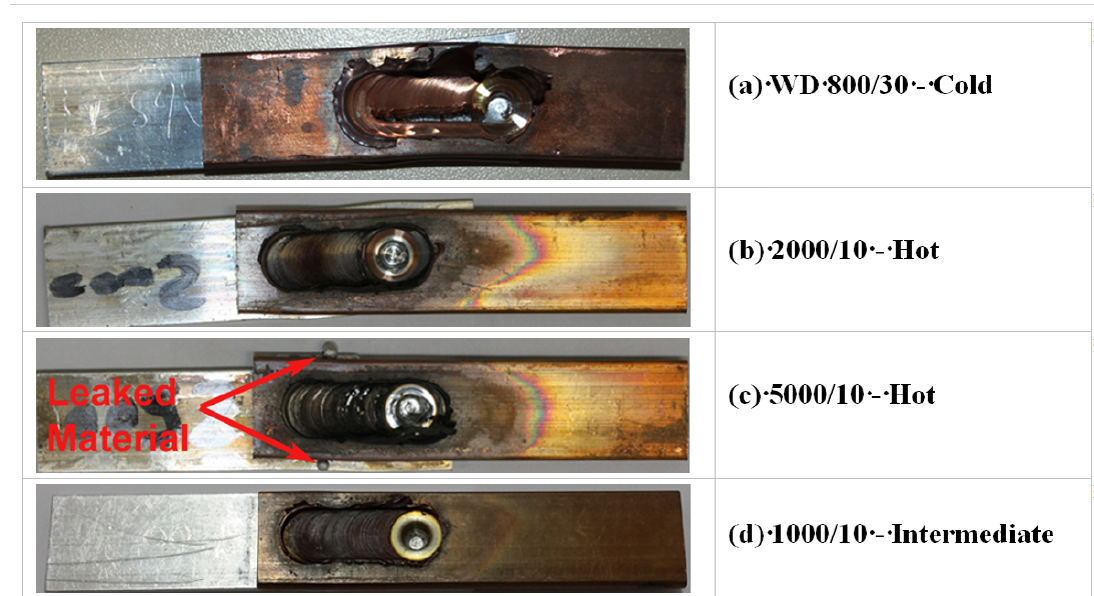
Figure 2. Visual inspection of welds produced with different rotational speeds and welding speed.